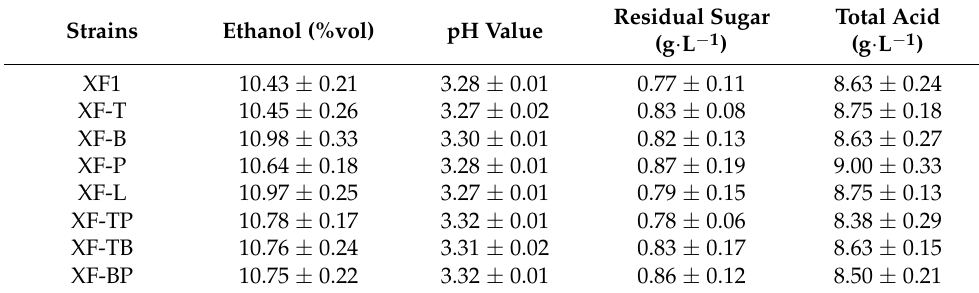
Values are expressed as means ± standard deviations from three independent tests ( p >